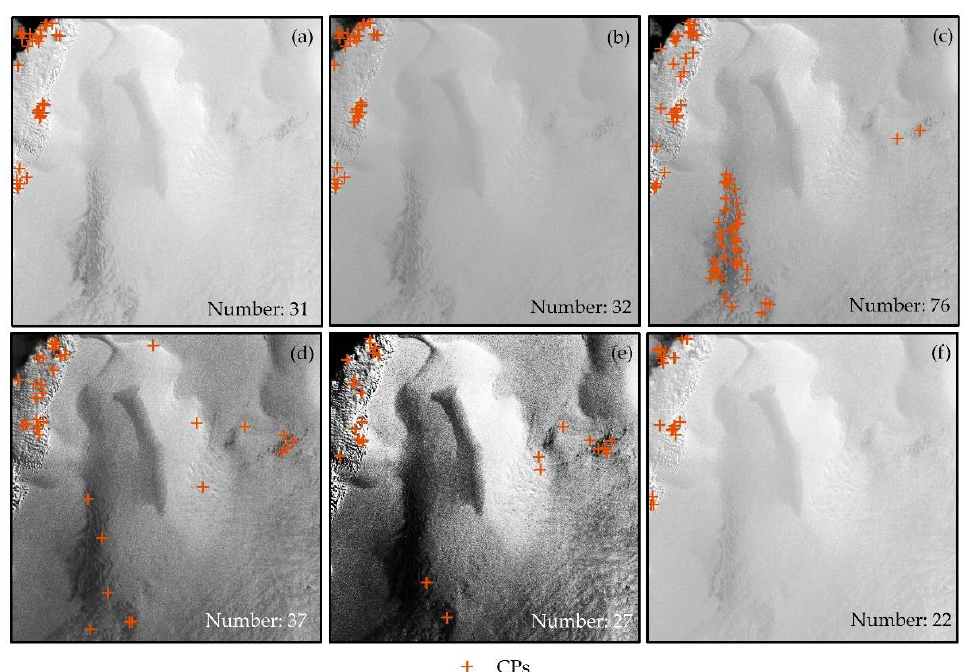
Figure 6. Comparisons of the number and distribution of CPs in the original image ( a ) and the image adopting different enhancement methods: ( b ) Linear; ( c ) Piecewise Liner; ( d ) Gaussian; ( e ) Equalization; ( f ) Square Root.